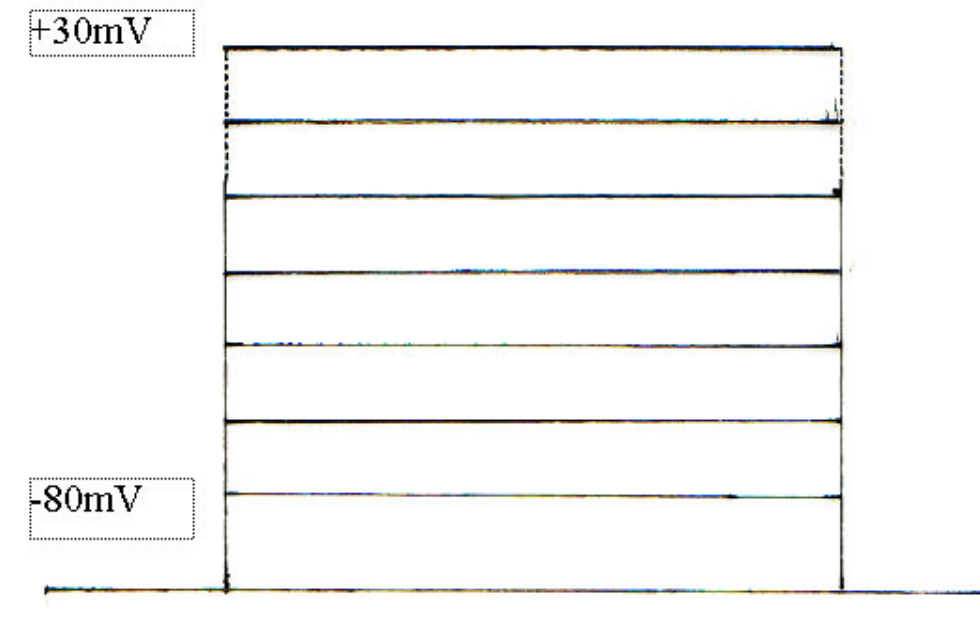
Figure 6c: Pulse protocol used for the measurement of